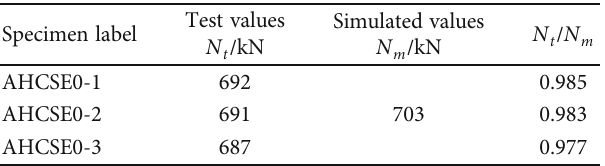
Figure 10: Numerical analysis and experimental comparison. Table 4: Comparison of test values and fi nite element calculated